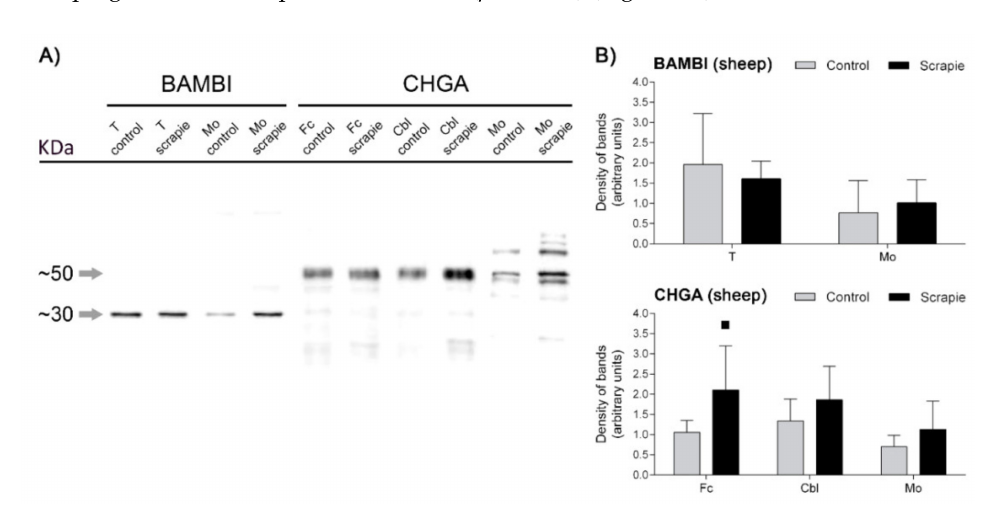
Figure 7. Western blot quantification of BAMBI and CHGA proteins in the CNS of scrapie-infected sheep. ( A ) Membranes displaying the specificity of antibodies against BAMBI and CHGA proteins in the ovine thalamus (T), medulla oblongata (Mo), frontal cortex (Fc) and cerebellum (Cbl) of control and scrapie-infected sheep detected using Western blot. Each protein was cropped and grouped from different parts of the same gel or from different gels. Distinctive bands of ~30 kDa and ~50 kDa confirmed the specificity of the antibodies used against BAMBI and CHGA, respectively. ( B ) Western blot quantification of BAMBI in T and Mo and CHGA in Fc, Cbl and Mo. Density of immunoreactive bands was normalized for β -Actin density band and is reported as arbitrary units. Data are expressed as means ± standard deviation. Quantification of density of bands did not reveal significant changes in any of the analysed areas, although CHGA displayed a trend to upregulation in scrapie animals (black bars) in Fc ( p = 0.097). Differences between groups were determined using the Student´s t -test ( (cid:110) p <